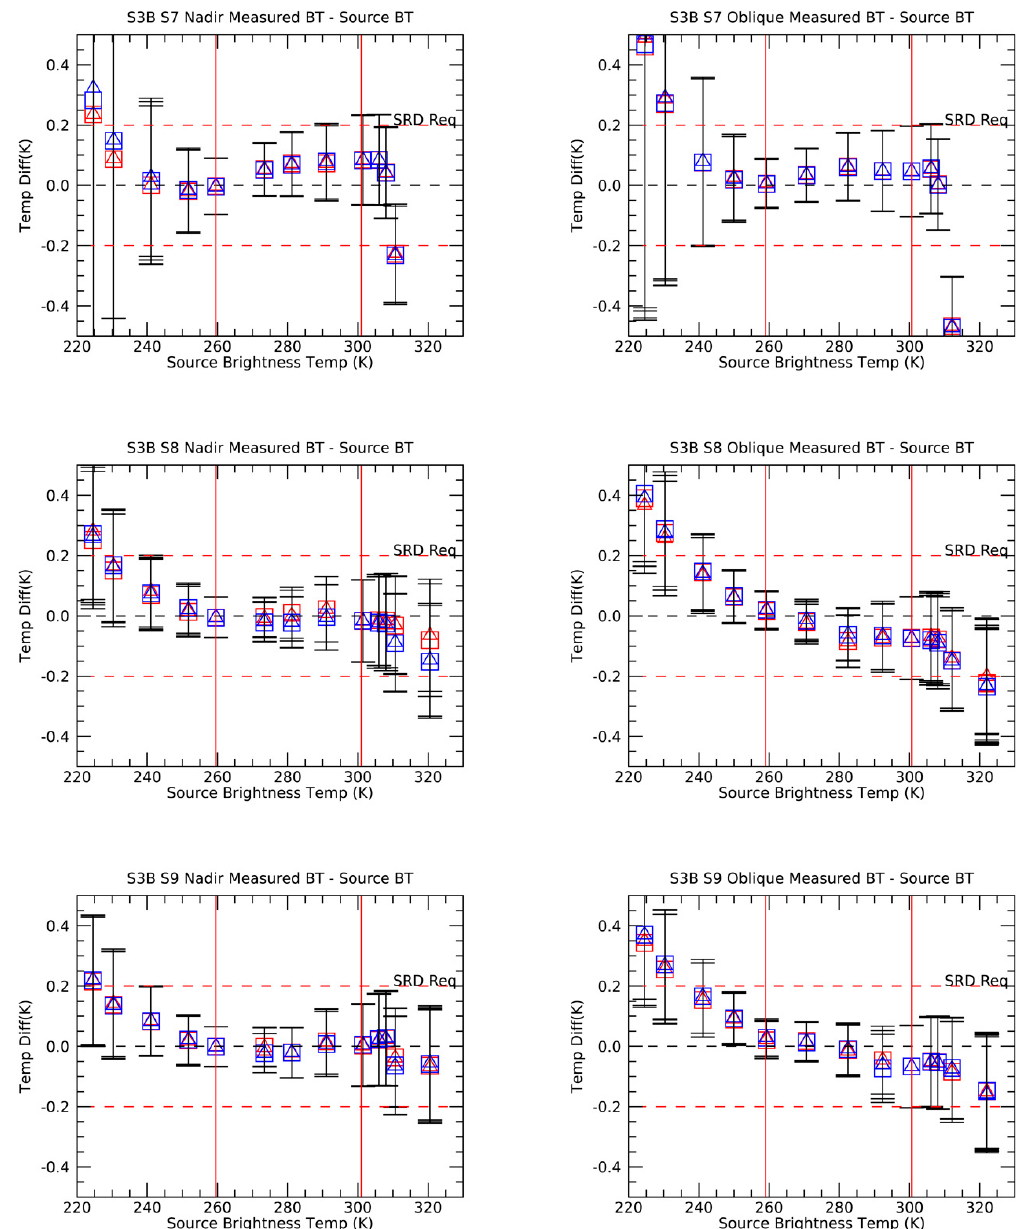
Figure 9. Differences between brightness temperatures of the external BB sources measured by SLSTR-B and the actual BB brightness temperatures. The vertical red-lines correspond to the temperatures of the on-board s. □ = Detector 1, Integrator 1; ☐ = Detector 1, Integrator 2; Δ = Detector 2, Integrator 1; Δ = Detector 2, Integrator 2. Error bars represent the combined uncertainty of the measurement at k = 3.